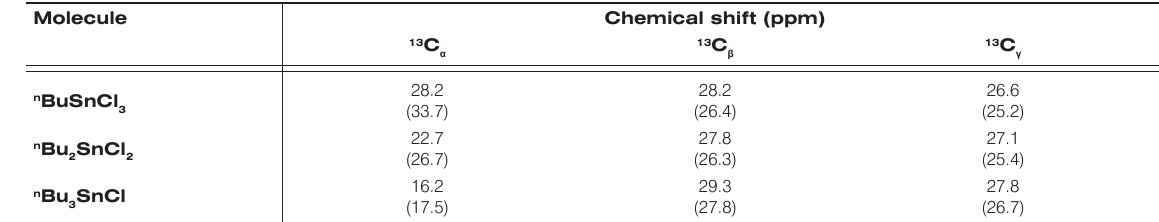
Figure 2. 119 Sn NMR chemical shift as a function of the number of X groups in the X experimental values are taken from [29,32], while the calculated 119 Sn chemical shift of SnCl chemical shifts were obtained using ONIOM(B3PW91:HF) and partitioning scheme III for the lowest-energy rotamers. The range on the vertical axis is reversed for ease of displaying the shape of the dependency. Table 3.